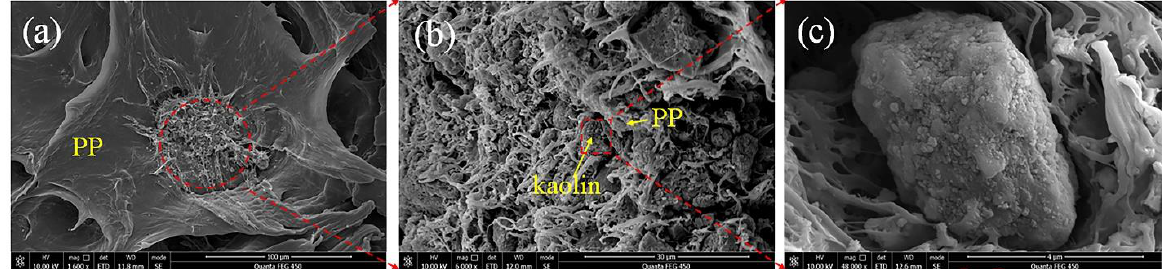
Figure 15. ( a ) ESEM image of fracture of 9KL/PP composite, ( b ) the aggregated kaolin region in ( a ), and ( c ) the kaolin in ( b